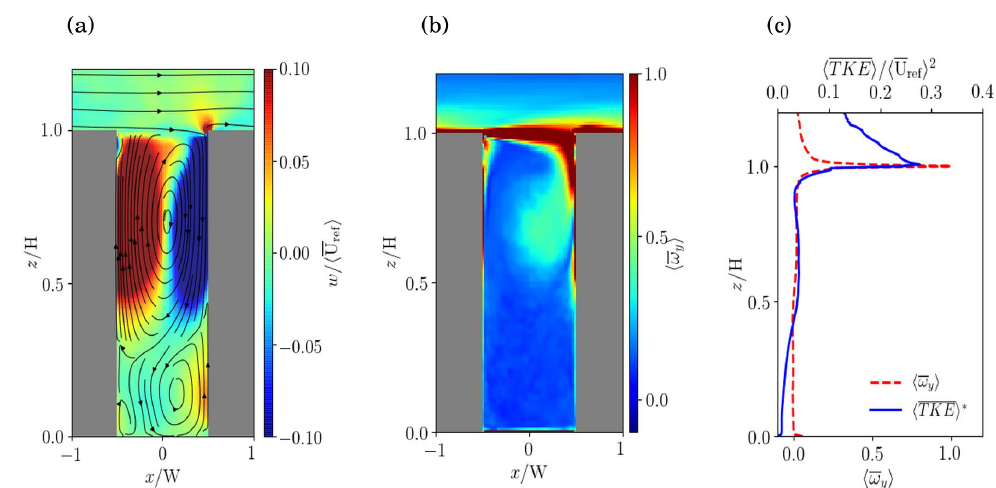
Figure 6. Flow structures for a deep canyon with AR = 3 and θ = 0°. ( a ) Temporally and spatially averaged streamlines; ( b ) spanwise vorticity; ( c ) vertical profiles of the TKE and spanwise vorticity. As in Figure 4, the streamlines and vorticity field are averaged in the spanwise